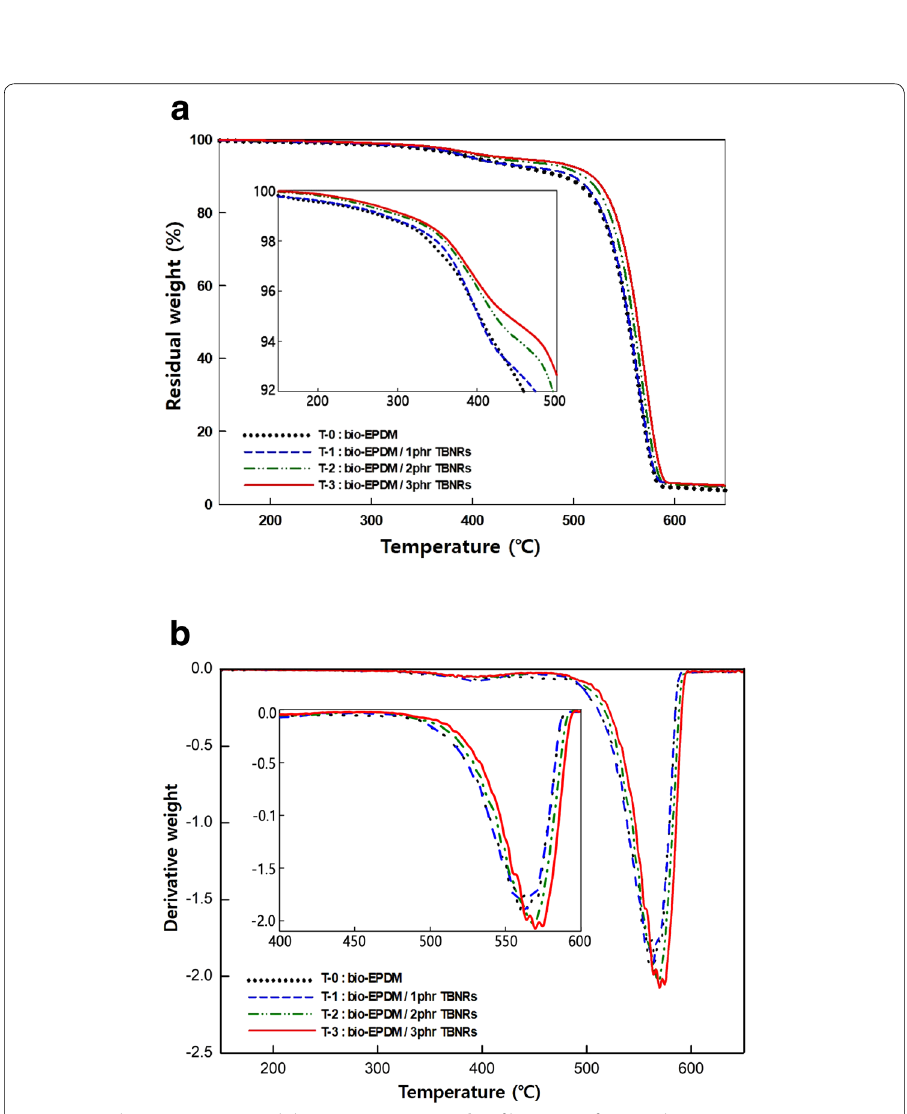
Fig. 6 TGA thermograms ( a ) and derivative TGA curves ( b ) of bio‑EPDM foam with